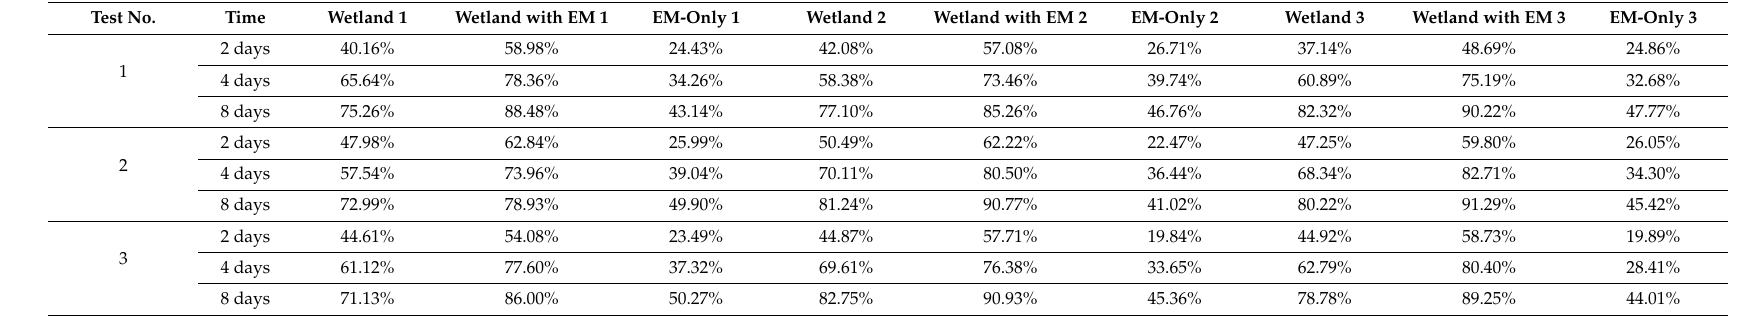
Table 2. TN concentration reduction rates in wetlands over 8